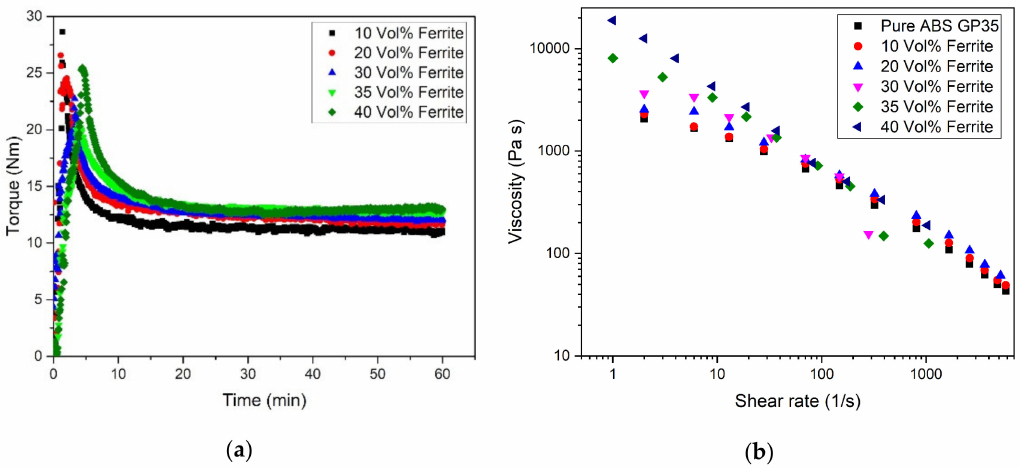
Figure 2. ( a ) resulting torque during compounding as function of compounding time and solid load; ( b ) shear rate and solid load dependent viscosity (at 240 ◦ C).